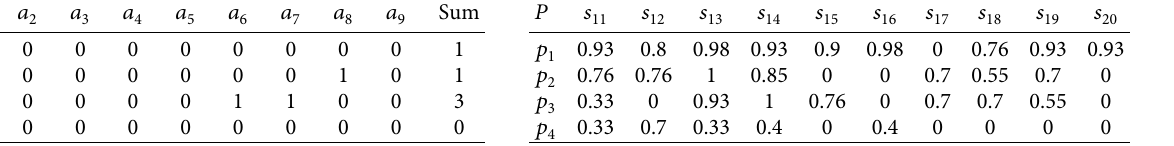
Table 19: Tabular representation of ( F